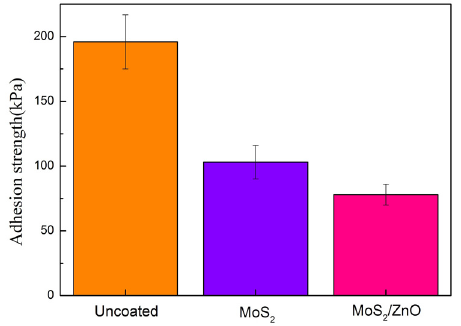
Figure 10. Adhesion strength of ice on GFRP, MoS 2 /PDMS, and MoS 2/ ZnO/PDMS nano-coating surfaces.